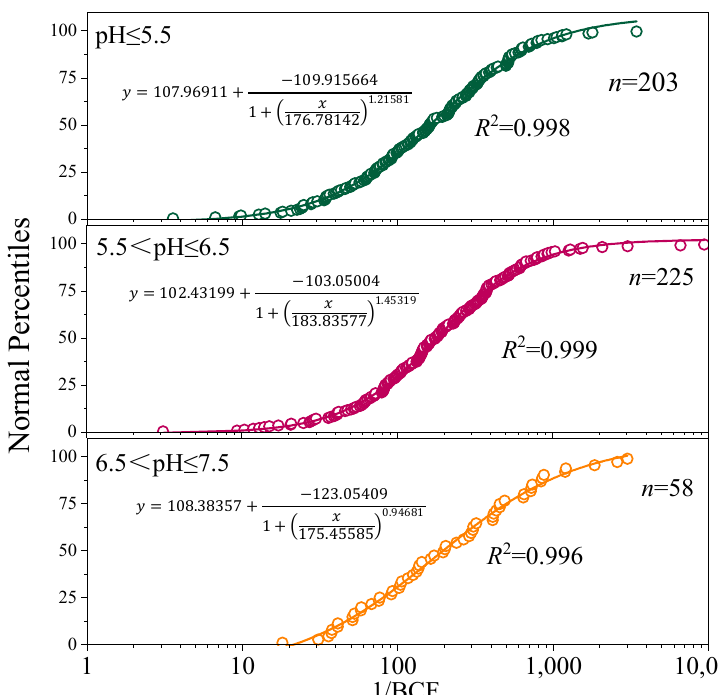
Figure 5. Species sensitivity distribution curves for Cd in maize in northwest Guizhou Province under different soil pH values.